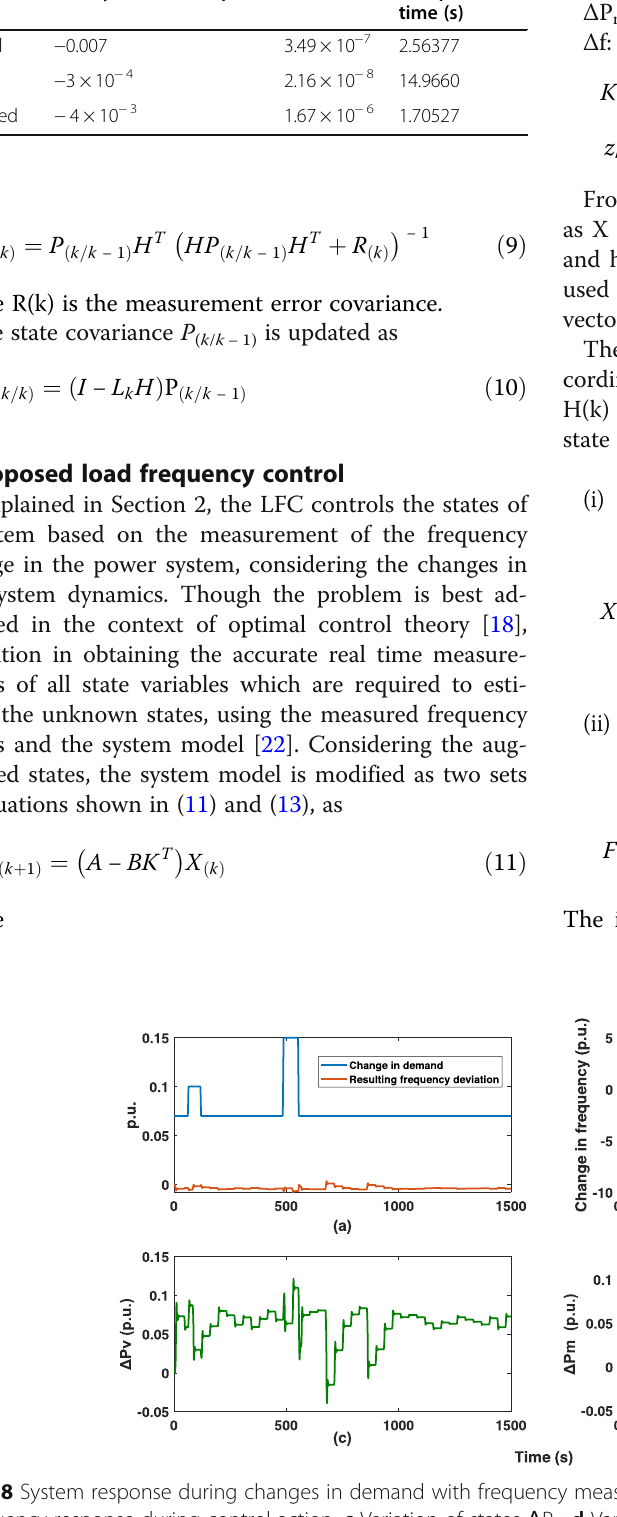
Table 2 Performance comparison of controllers corresponding to a measurement noise variance of 0.005 Controller Steady state error (p.u.) Variance